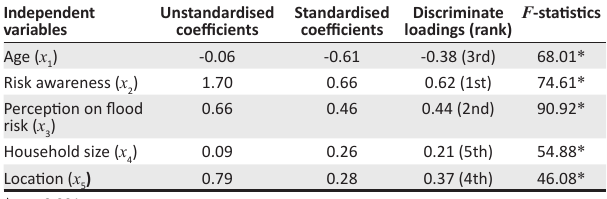
TABLE 6: Summary of measures in the discriminant analysis ( n =